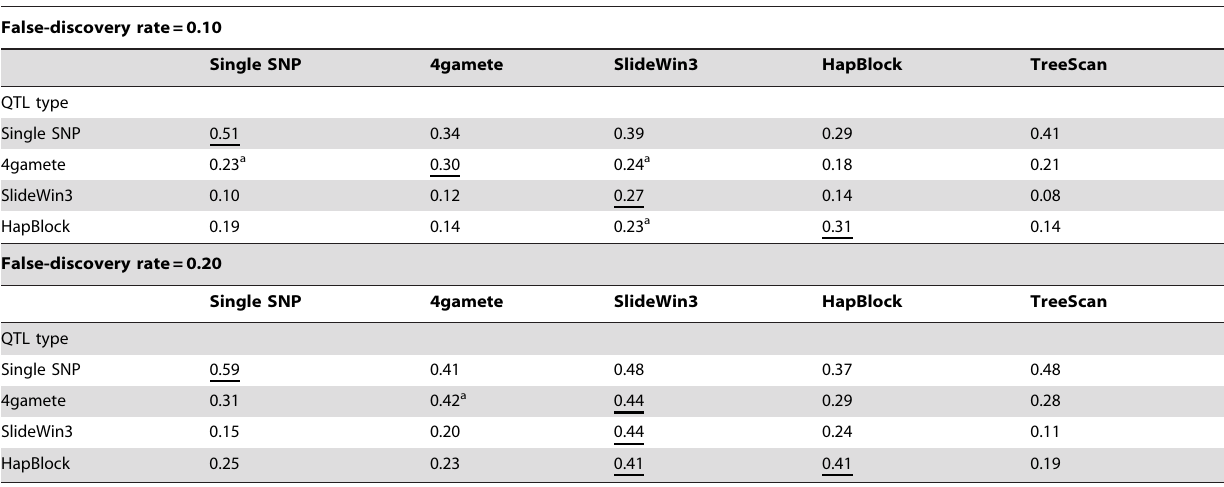
Table 4. Power of detecting single causal SNPs left in the marker dataset or QTL pairs chosen on the basis of the different block methods (rows) for each analysis method (columns).